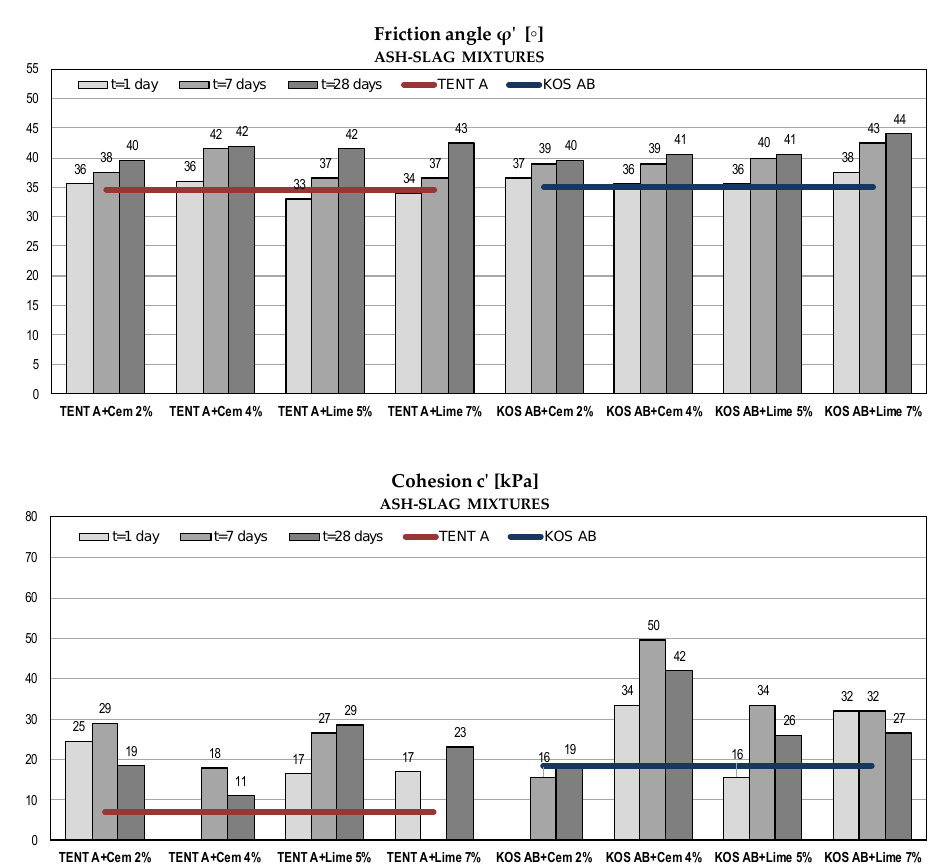
Figure 9. Shear strength parameters of ash-slag samples with binders (some test results were omitted because obtained values were too high).